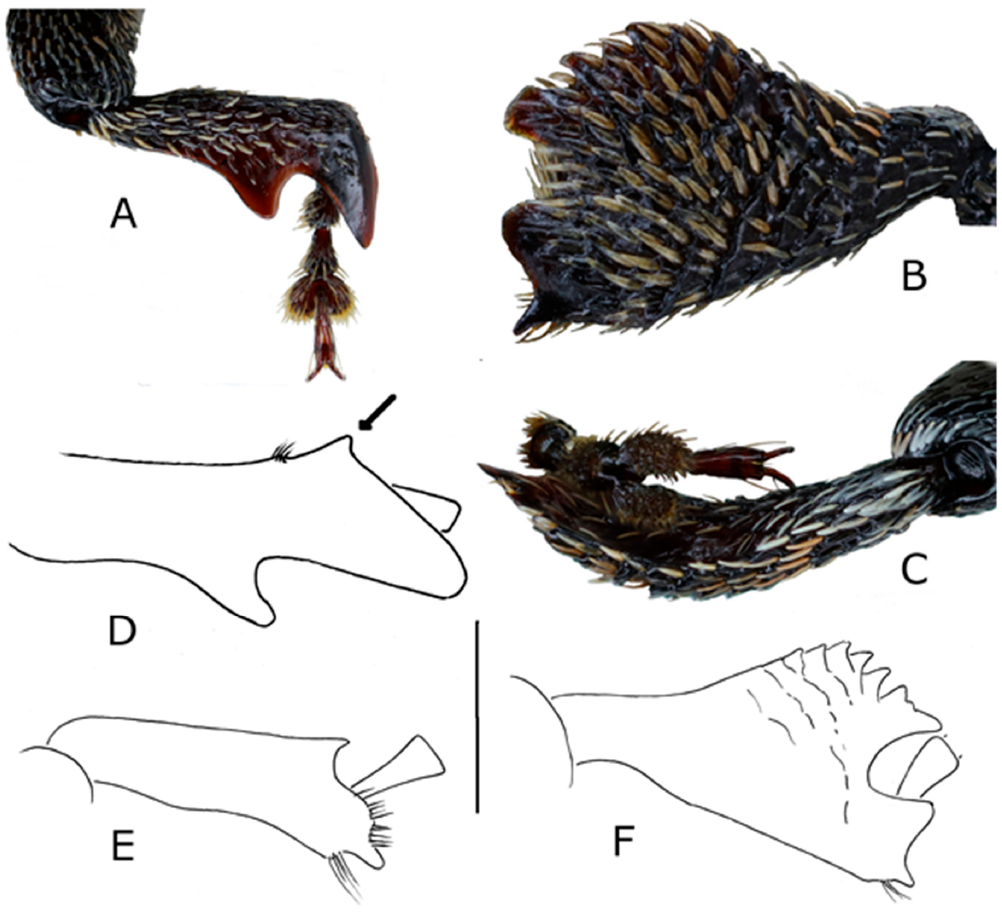
Figure 15. Sclerocardius kuscheli sp.nov. tibiae: ( A ) fore tibia, right, ( B ) hind tibia, anterior right, ( C ) hind tibia, dorsal right, ( D ) fore tibia, antero-apical, to show premucro (arrowed), ( E ) mid tibia, anterior left, and ( F ) hind tibia, anterior right. Scale bar (line drawings only) 1 mm. and ( F ) hind tibia, anterior right. Scale bar (line drawings only) 1 Abdomen . Tergites I-V weakly sclerotised, VI and VII more strongly sclerotised. Male tergite VII